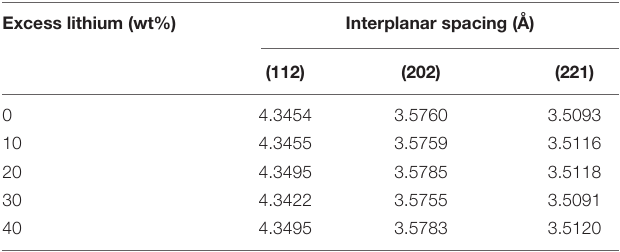
TABLE 1 | The partial interplanar spacing of different Li 2 O excess LTPO obtained from XRD. Excess lithium (wt%) Interplanar spacing (Å)